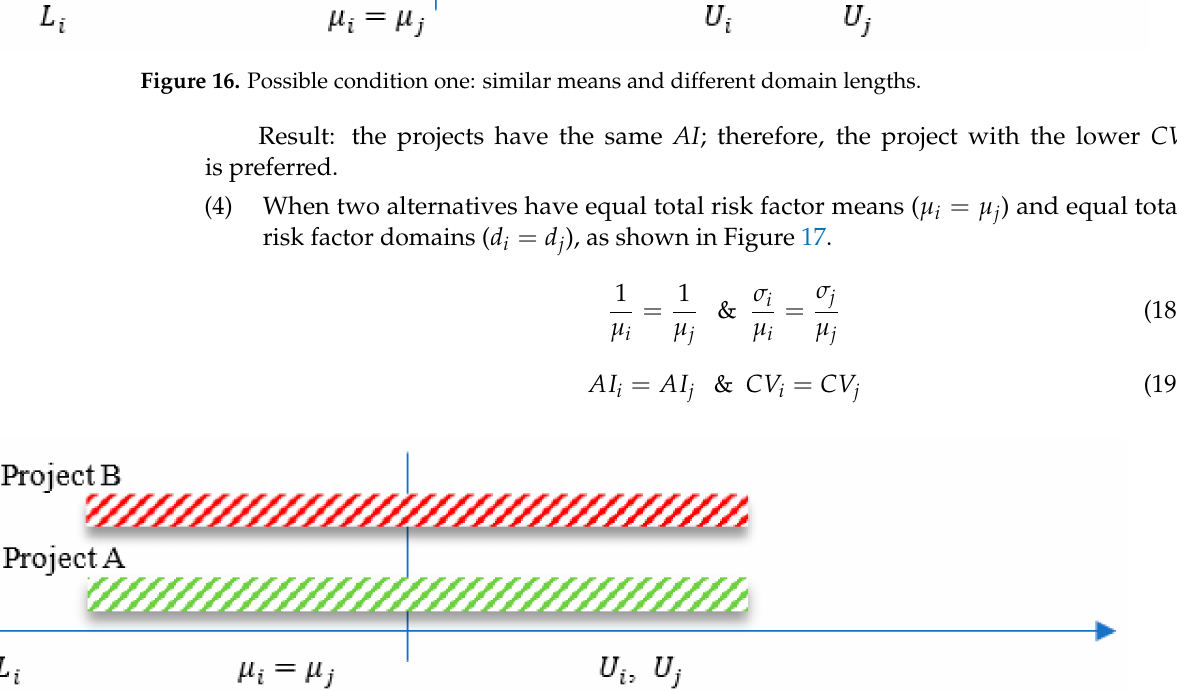
Figure 17. Possible condition one: similar means and similar domain